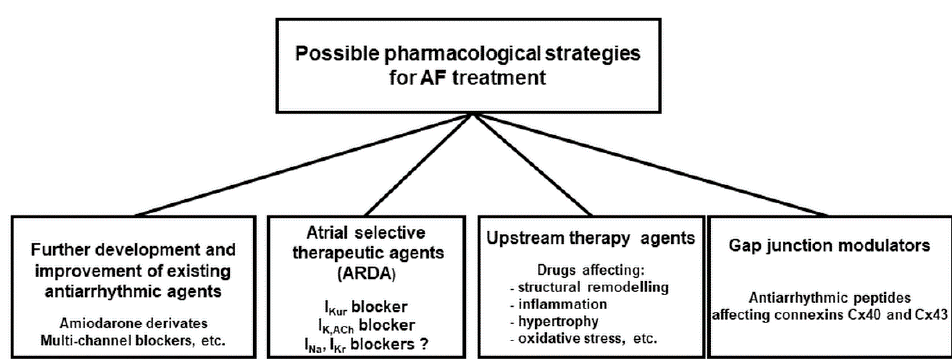
Figure 4. Possible pharmacological investigational strategies for developing new antiarrhythmic drugs for treating AF.